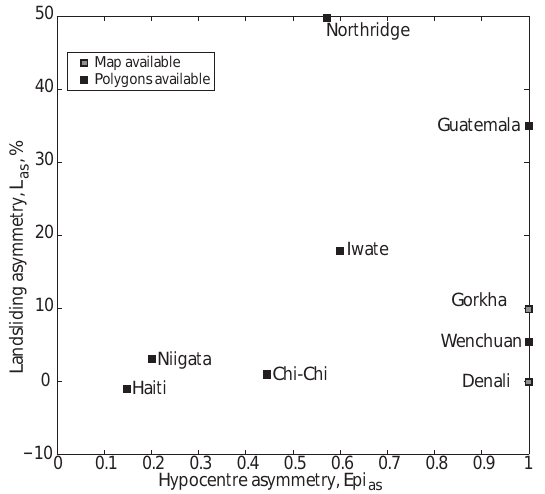
Figure 7. Hypocentre asymmetry (0 = centre, 1 = tip of the fault) against along-strike landsliding asymmetry, defined by the differ- ence between the total landslide area beyond the tip of the fault op- posed to the epicentre and the total landslide area beyond the other tip normalized by the total landslide